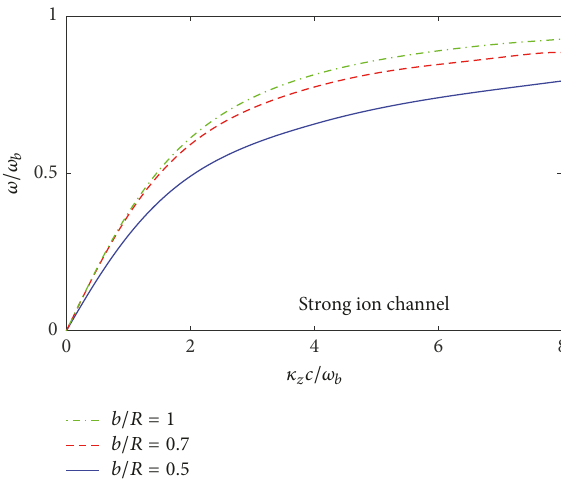
Figure 4: The influence of the ratio 𝑏/𝑅 on the dispersion curves of the SC 01 waves for strong ion channel with 𝜔 𝛽 = 2.3195 . The inner radius of the annular beam is taken as 0.25 R . 𝑏/𝑅 = 1 represents the waveguide completely filled with the annular beam.